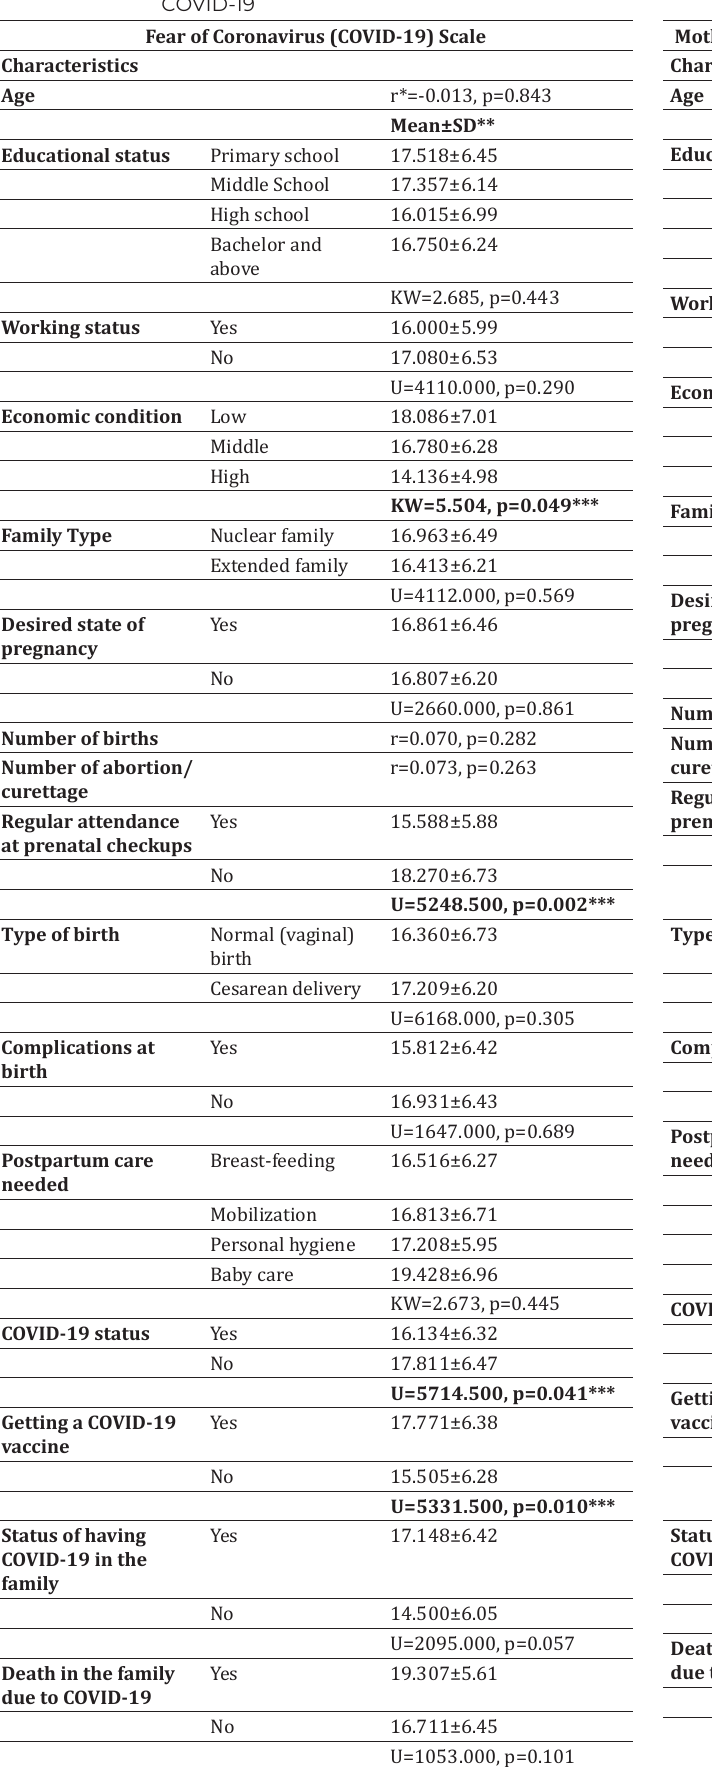
Factors Affecting the Mean Mother to Infant Bonding Scale Scores According to Women's Socio-Demographic, Obstetrical Characteristics and Knowledge about COVID-19